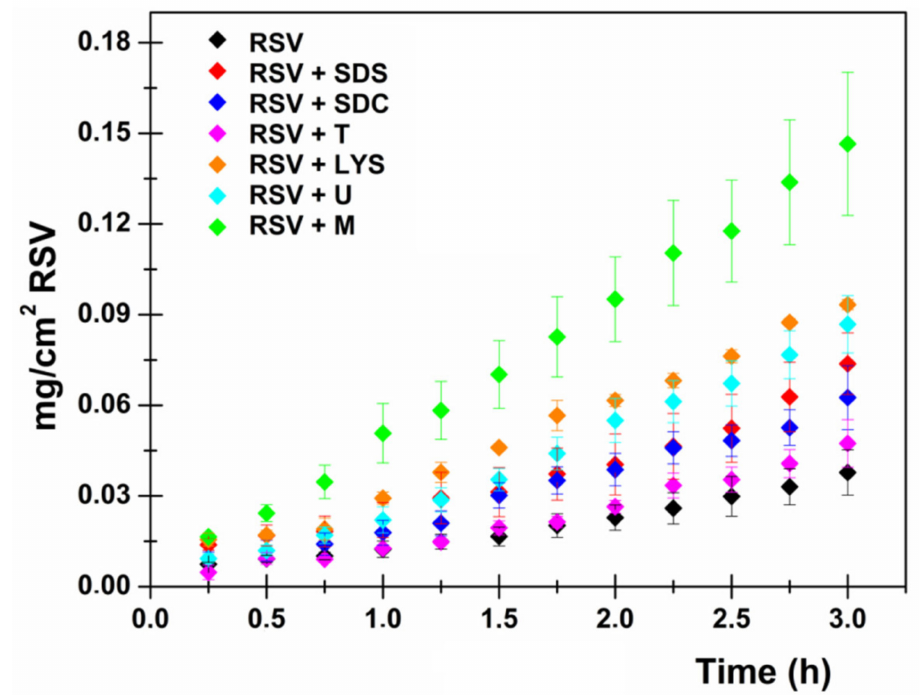
Figure 2. RSV permeation profiles in the absence and in the presence of CPEs. RSV (mg/cm 2 ) permeated as a function of incubation time (h) after administration of RSV solution 1 mg/mL (black) and RSV solution 1 mg/mL + 0.2 mg/mL of sodium dodecylsulfate (red), sodium dehydrocolate (blue), Transcutol ® (pink), lysine hydrochloride (orange), urea (light blue) and menthol (green). Results are presented as means ± SE ( n =